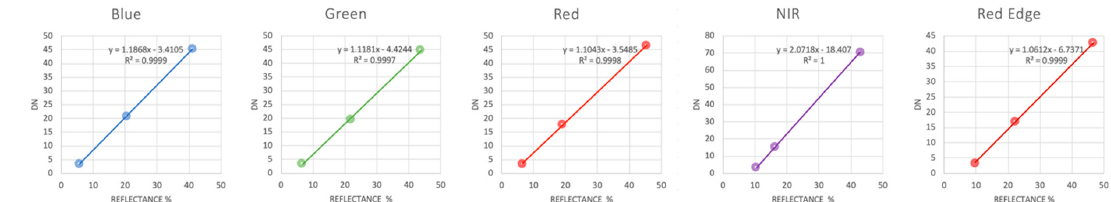
Figure 4. The linear relationships between digital number (DN) value and reflectance of the calibration tiles in the MicaSense camera’s five spectral bands.